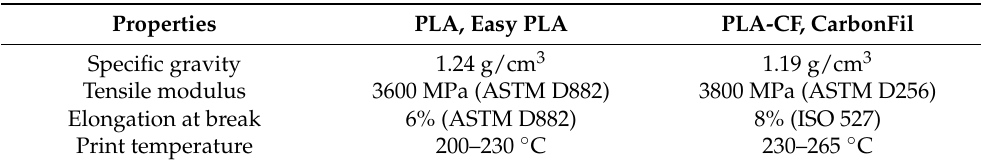
Table 1. Mechanical properties of polylactic acid (PLA) and polylactide and carbon fiber (PLA- CF)